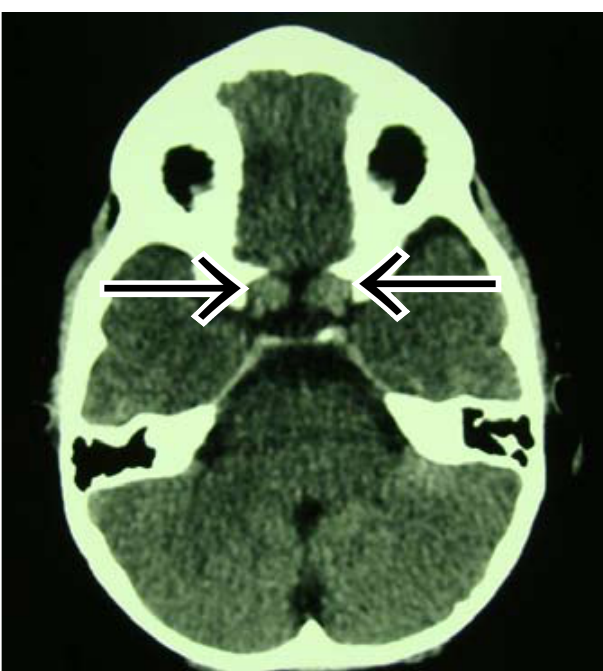
Fig. 3a. Axial non-enhanced brain CT showing bilateral gliomas at the level of the optic nerve extending into the chiasm.